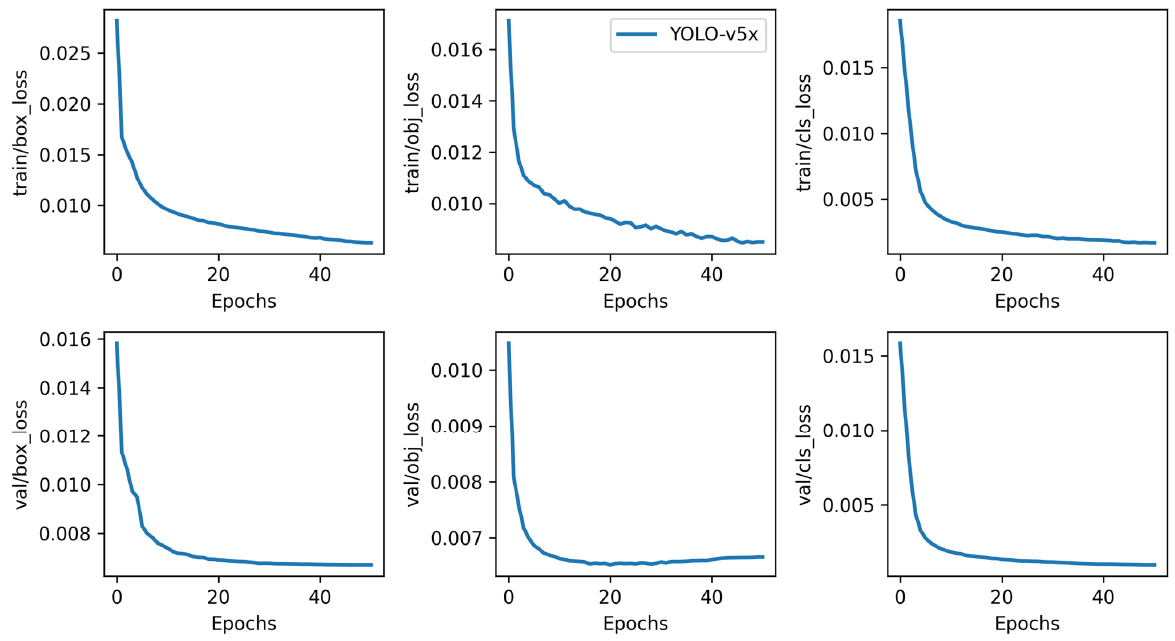
Figure 16. Training and validation loss functions of the proposed VPP framework based on YOLOv5x over 50 epochs using whole DAL-annotated VP images.